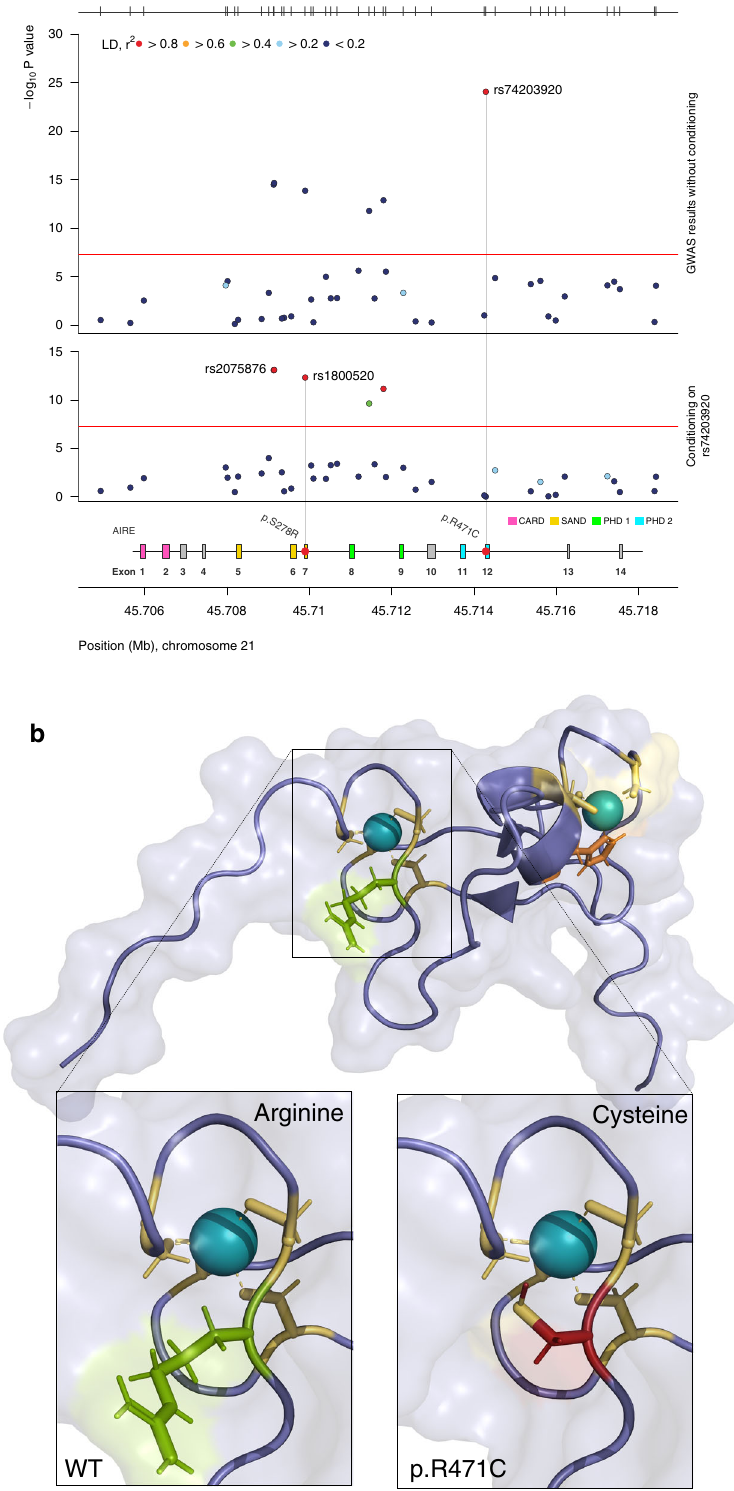
Fig. 2 Two coding variants in the Autoimmune Regulator gene ( AIRE ) are independently associated with autoimmune Addison ’ s disease. a GWAS results without (upper panel) and with (lower panel) conditioning, on the top SNP rs74203920. The secondary association peak, including rs1800520, remains equally signi fi cant after conditioning re fl ecting its independent association. The – log 10 P values from logistic regression of 1223 cases and 4097 controls are plotted against their physical chromosomal position. The red bars represent the genome-wide signi fi cance level (5 × 10 − 8 ). b The location and consequences of the coding change p.R471C in the PHD2 domain of AIRE. The additional charge from the cysteine residue (red) is in close proximity to the zinc ion (teal). Arginine is marked in green, histidine in orange, and wildtype (WT) cysteines in